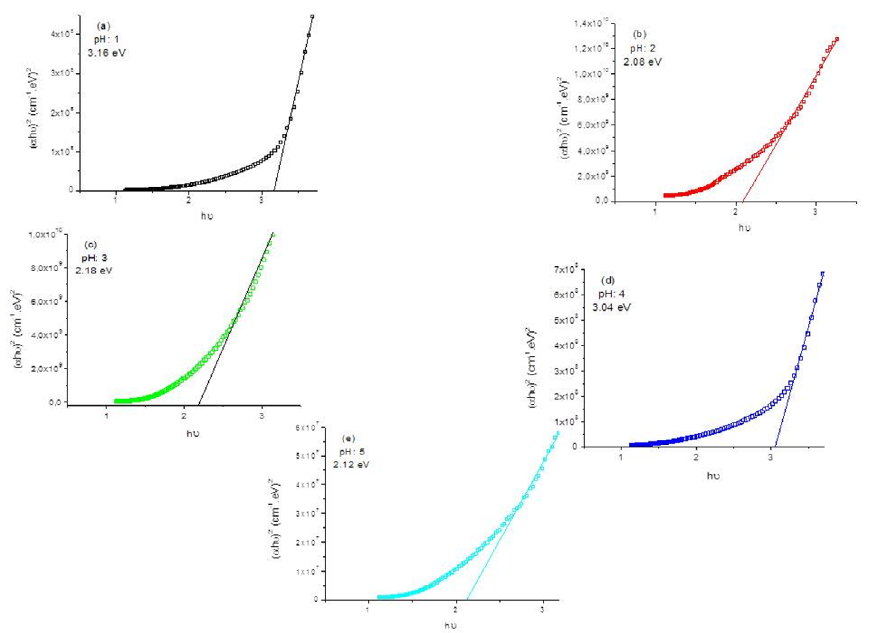
films produced at different pH: (a) pH 1, (b) pH 2, (c) pH 3, (d) pH x